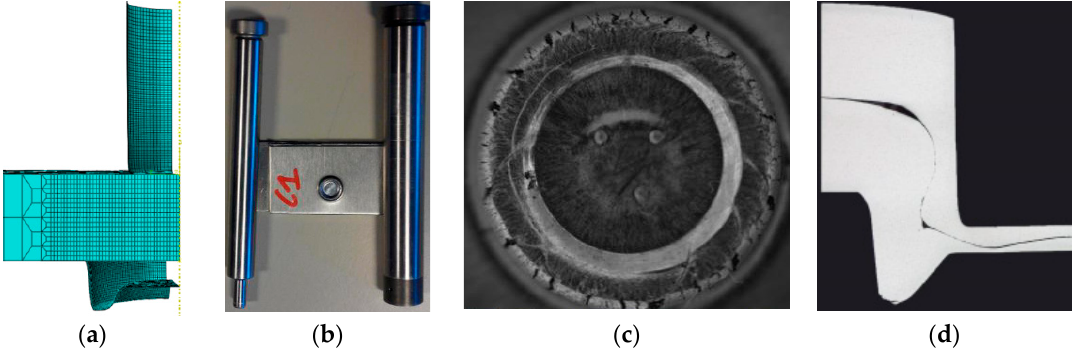
Figure 4. Simulation model, experiment tools and specimen. ( a ) 3D model; ( b ) specimens and tools; ( c ) the clinched joint with a fracture; and ( d ) the crack happening in the groove of the clinched joint.